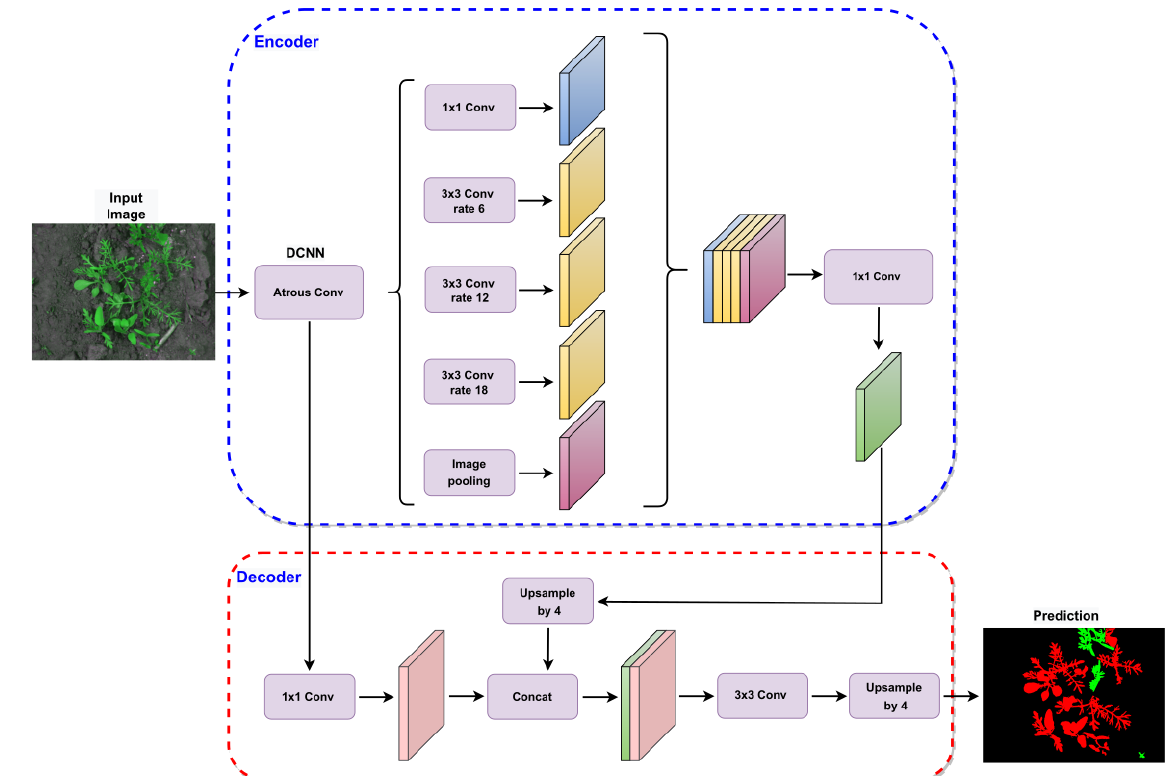
Figure 4. DeepLabV3 model illustration, adapted from